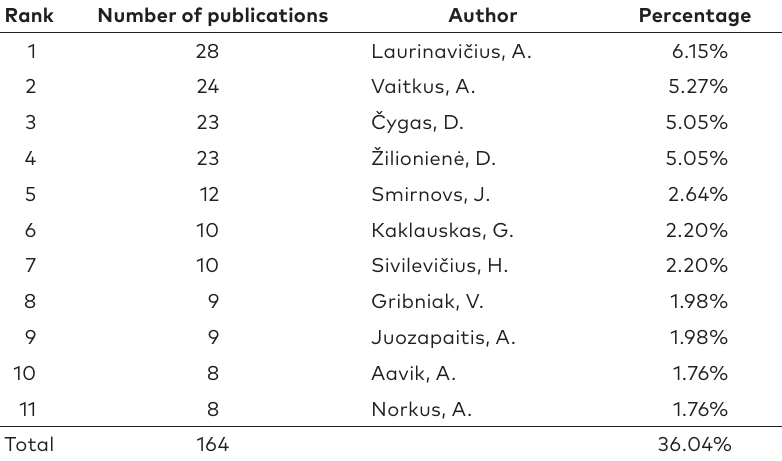
Table 7. Top eleven productive authors in